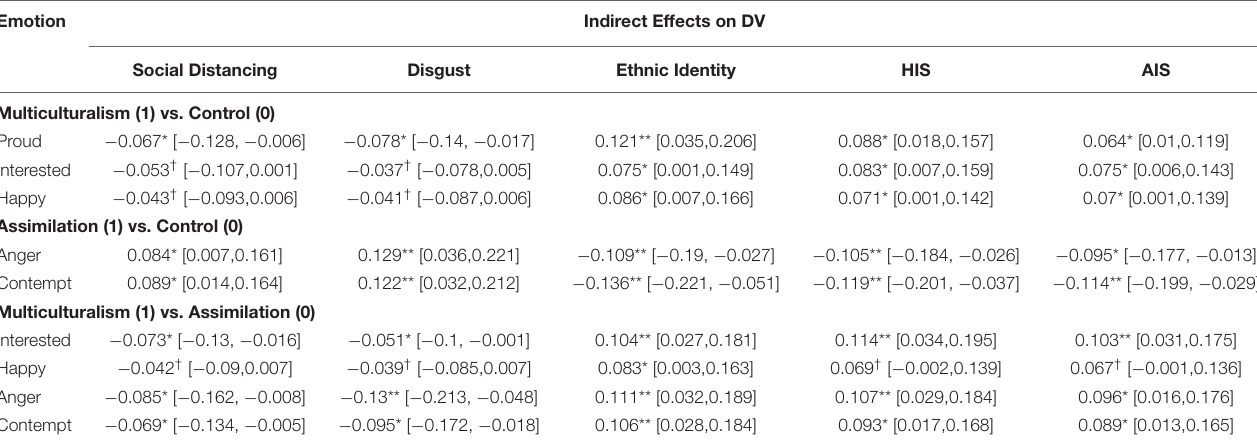
TABLE 4 | Summary of the indirect priming effects through specific emotions in study